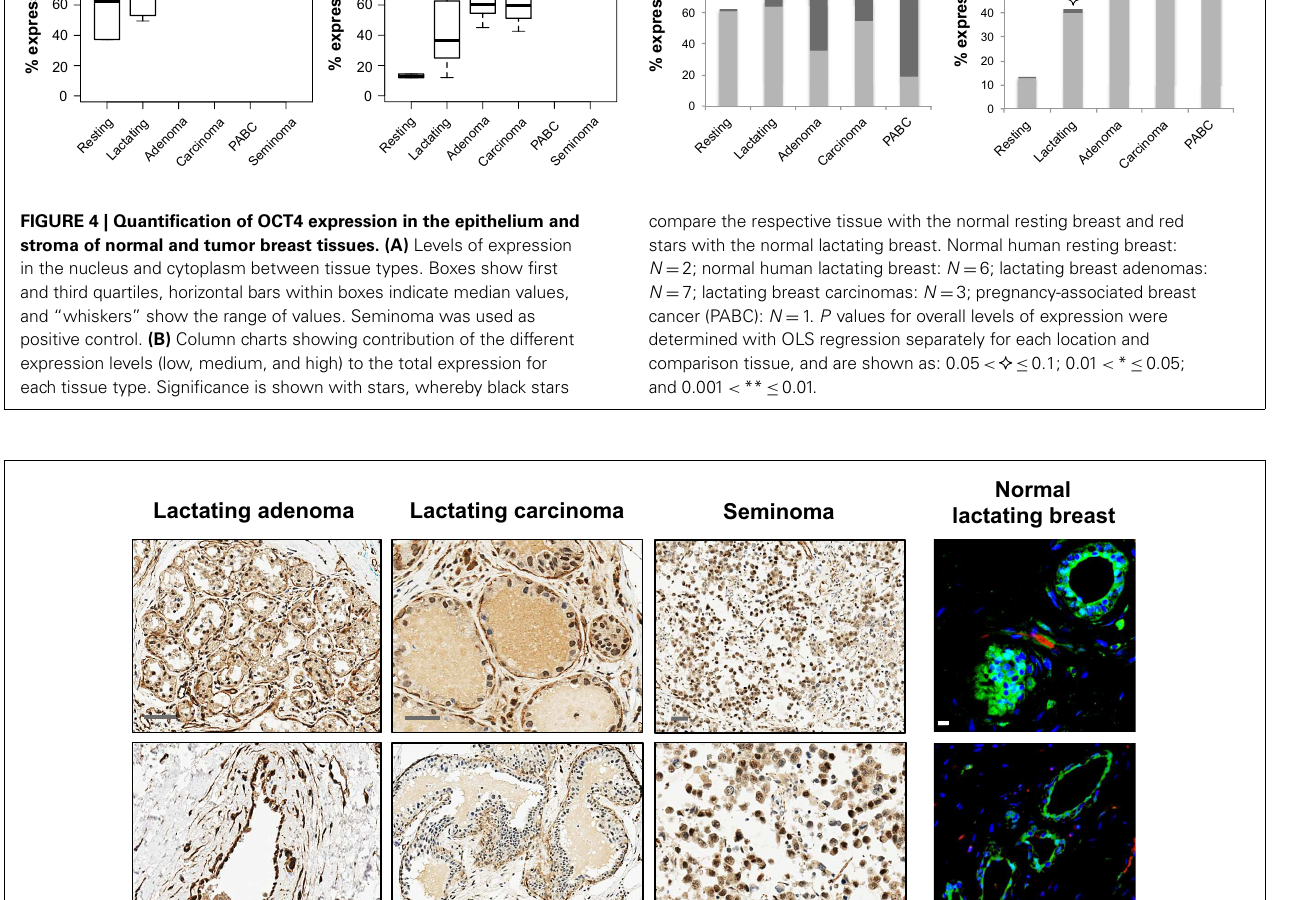
FIGURE 5 |Additional examples of OCT4 expression by IHC and IF in the normal lactating and breast tumor tissues examined. Seminomas were used as positive control. Scale bars: 50 µ m (IHC), and 10 µ m (IF).